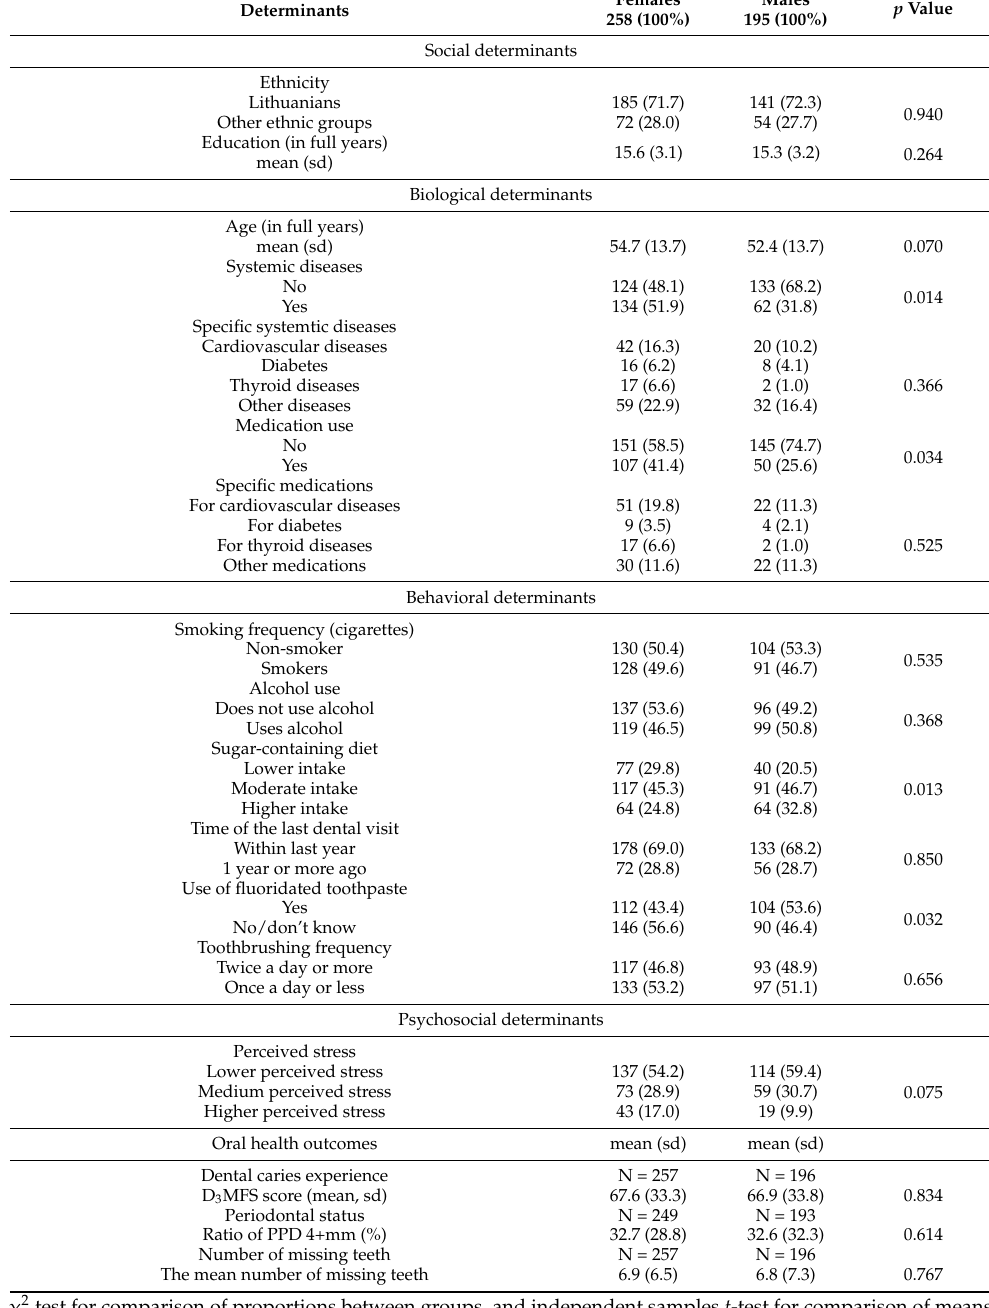
Table 2. Sex-stratified social, biological, behavioral, and psychosocial determinants’ distribution among Vilnius